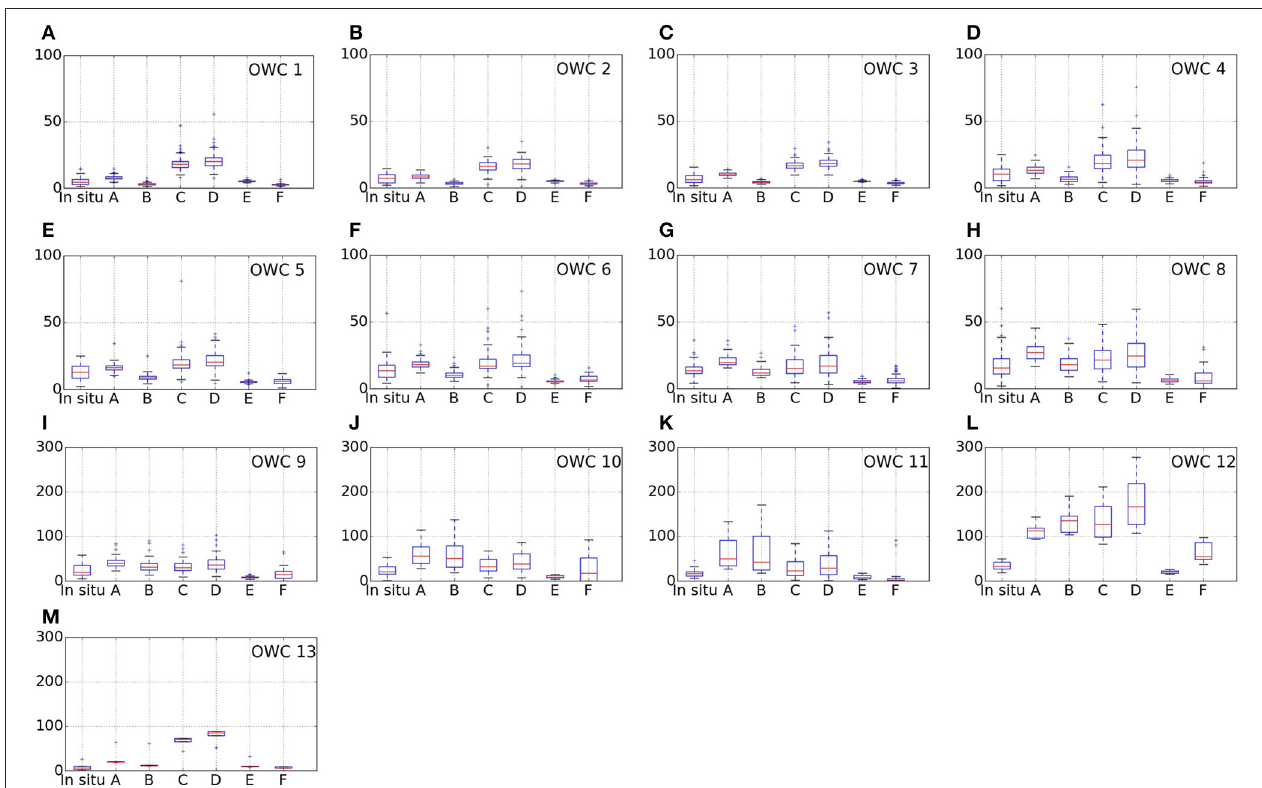
FIGURE 6 | Box-whiskers plots of C phy (in mgCm − 3 ) for the optical water classes (OWC in the figures) 1–13 corresponding to sub-figures (A–M) respectively. The output of each algorithm (A–F) is compared to the in situ measurement for each optical water type. Note change of vertical scale in plots (I–M) , corresponding to optical water classes greater than 9. Box, Inter Quartile Range (IQR); red line, median; whiskers, ± 1.5 ×